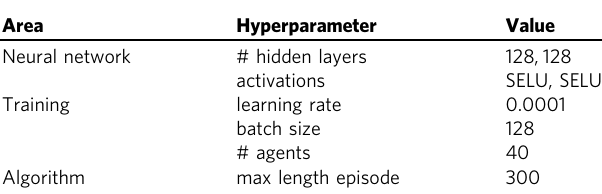
Table 2 List of the hyperparameters and their values used in the problem of quantum compiling by rotations operators. The proximal policy optimization agent (PPO) exploits scaled exponential linear units (SELU) as nonlinear activation functions in the hidden layers of the neural